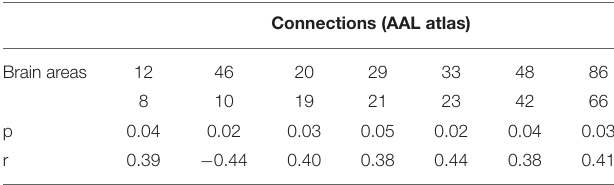
TABLE 2 | The connection significantly correlated with the CLCDS